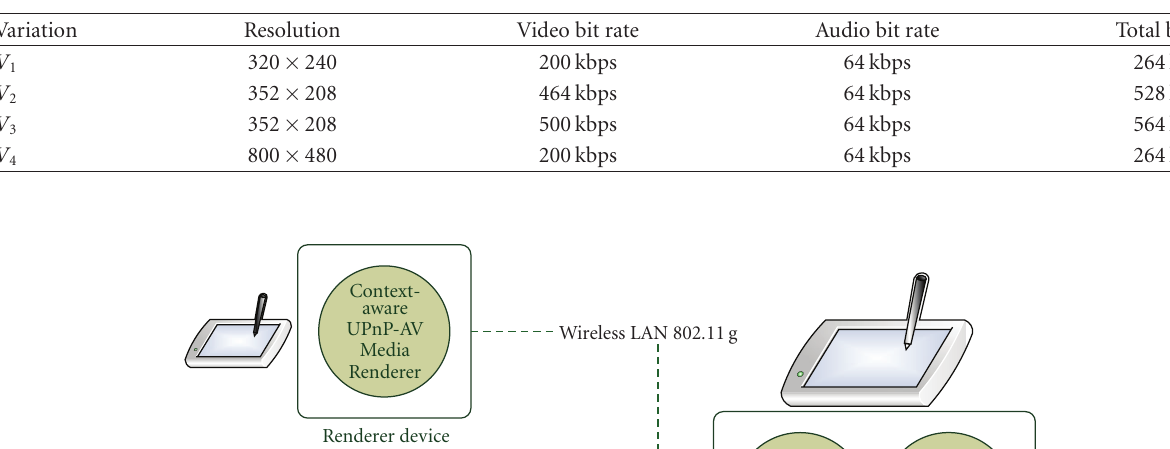
Table 1: Test stream variations.